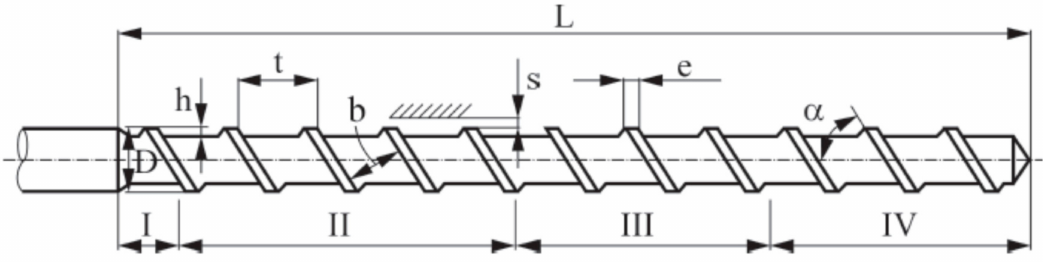
Figure 3. Construction diagram of the screw: I—hopper zone, II—feeding zone, III—conversion zone, IV—metering zones; L = 800 mm, D = 32 mm, h = 4 mm, t = 45 mm, e = 5 mm, s = 0.9 mm (the distance between the outer surface of the coil and the inner surface of the extruder barrel), α = 60 ◦